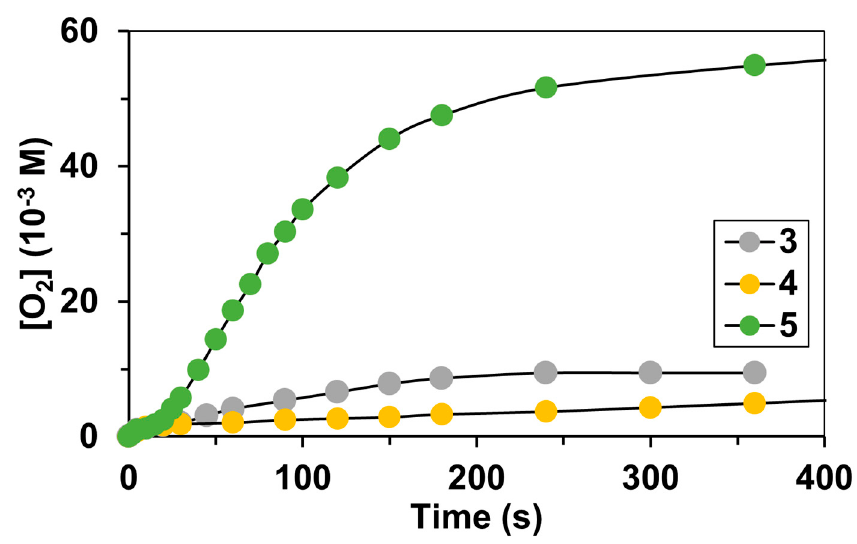
Figure 6. Time traces for the 3 P – 5 P -mediated disproportionation reaction of H 2 O 2 : [ 3 - 5 ] 0 = 1.0 × 10 − 3 Table 2. Comparison of the catalase-like activity of [Fe II (L 1 -L 5 )] 3 ](CF 3 SO 3 ) 2 ( 1 – 5 ) complexes at 298 K. Catalyst